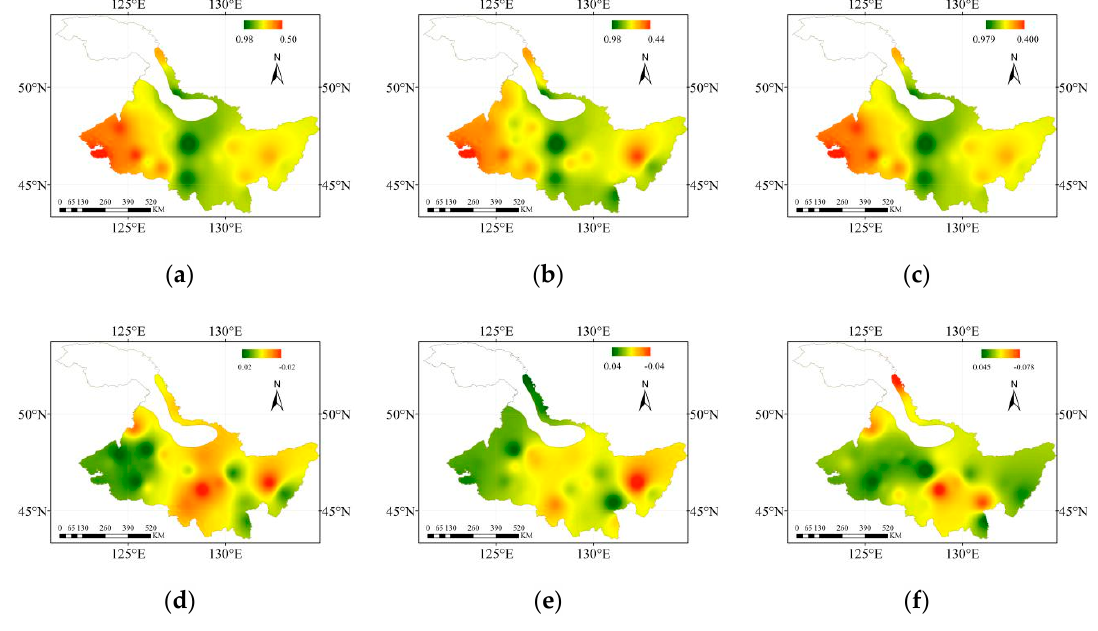
Figure 6. Average coupling degree of ET c and P e during ( a ) 1960–1979, ( b ) 1980–1999, and ( c ) 2000– 2015. Climate tendency rate of coupling degree of ET c and P e during ( d ) 1960–1999, ( e ) 1980–2015, and ( f )